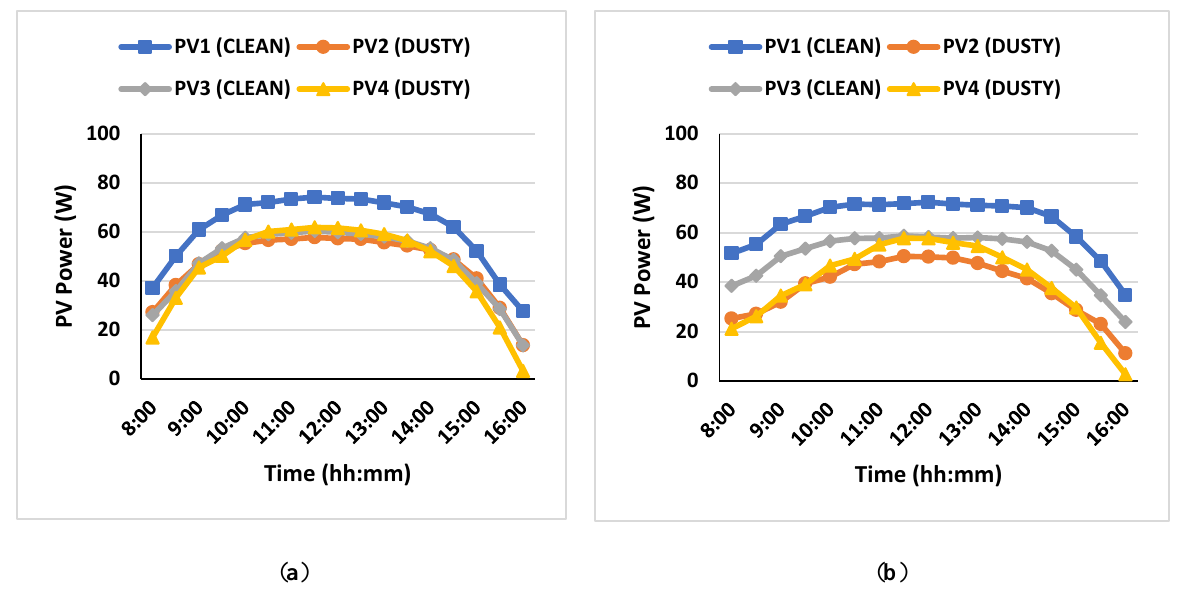
Figure 7. Comparison of clean and dusty PV performance for: ( a ) first day; and ( b ) after three weeks of the experiment.